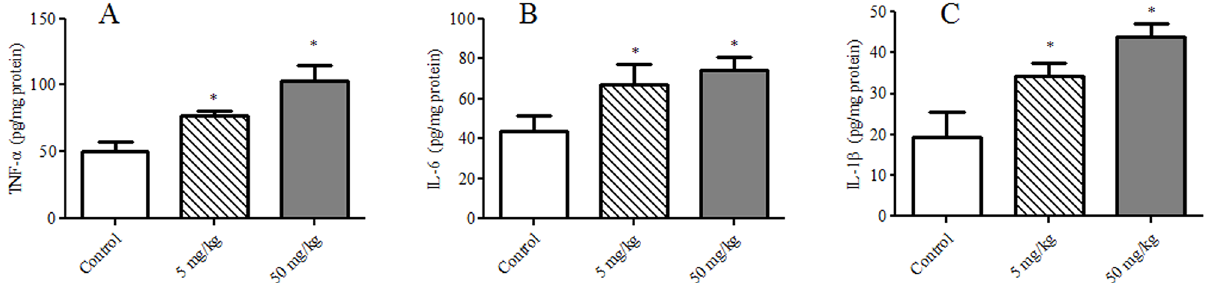
Fig 5. The effects of TDBP-TAZTO (5 and 50 mg/kg) on pro-inflammatory cytokines level in the hippocampus. The results are presented as mean ± SE (n = 5/group). For statistical significance, * p < 0.05, vs. control group.